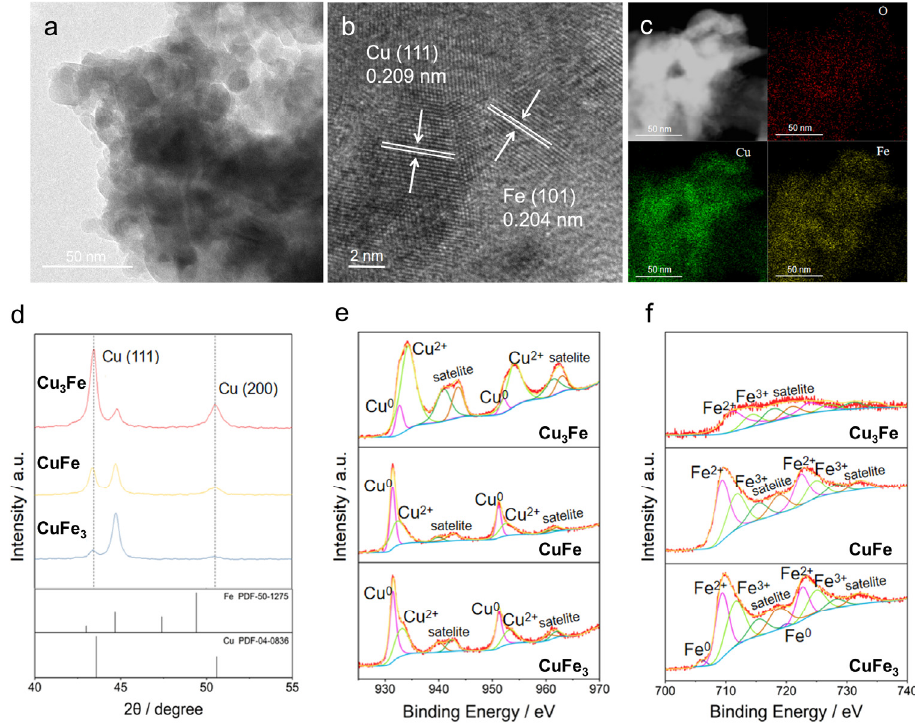
Figure 1. ( a ) TEM image ( b ) HRTEM image ( c ) EDS mapping image of Cu 3 Fe; ( d ) XRD patterns ( e ) XPS Cu 2p spectra ( f ) XPS Fe 2p spectra of the Cu 3 Fe, CuFe and CuFe 3 , respectively.